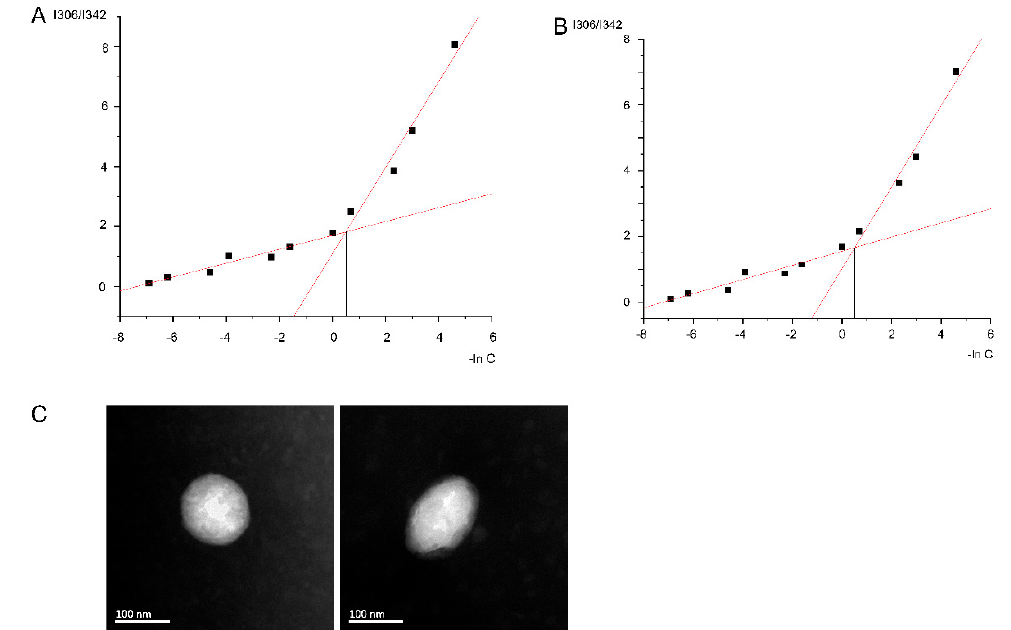
Figure 2. Critical micellar concentration (CMC) determination of HA ( A ) and ATRA-SS-HA ( B ) nano micelles. ( C ) TEM image of Cur@HA(L) and Cur@ATRA-SS-HA(R) nano micelles. Scale bar was 100 nm.